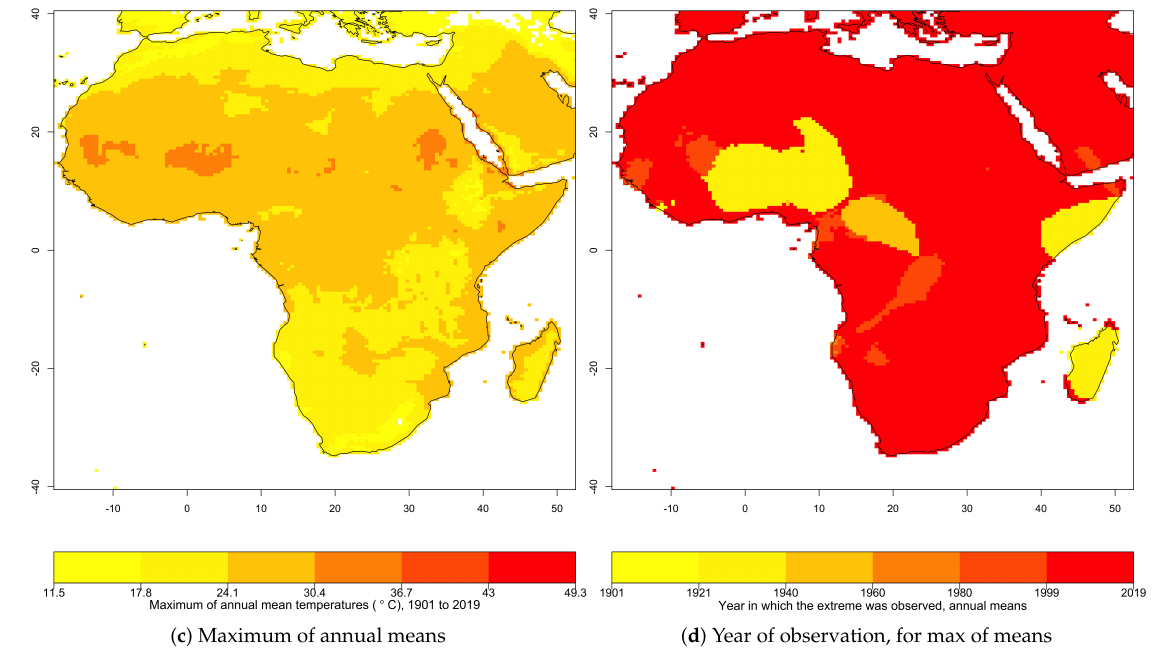
Figure 2. The two thresholds that define extreme event in this study (90th percentiles of distributions over 1901 to 2000 and 1901 to 2019) for annual maxima and annual means; and difference between these: ( a ) the 90th percentile of annual maxima over 1901 to 2000, ( b ) the 90th percentile of annual means over 1901 to 2000, ( c ) the 90th percentile of annual maxima over 1901 to 2019, ( d ) the 90th percentile of annual means over 1901 to 2019, ( e ) difference between the 90th percentiles of annual maxima [c a] and ( f ) difference between the 90th percentiles of annual means [d b]. − −